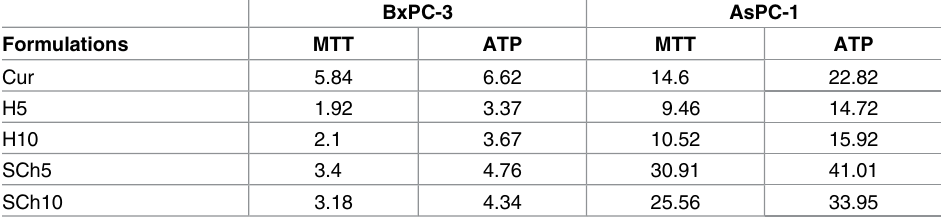
Table 3. Comparison of IC50 values of cytostatic agents using MTT and ATP Assayson BxPC-3 and AsPC-1 cells.